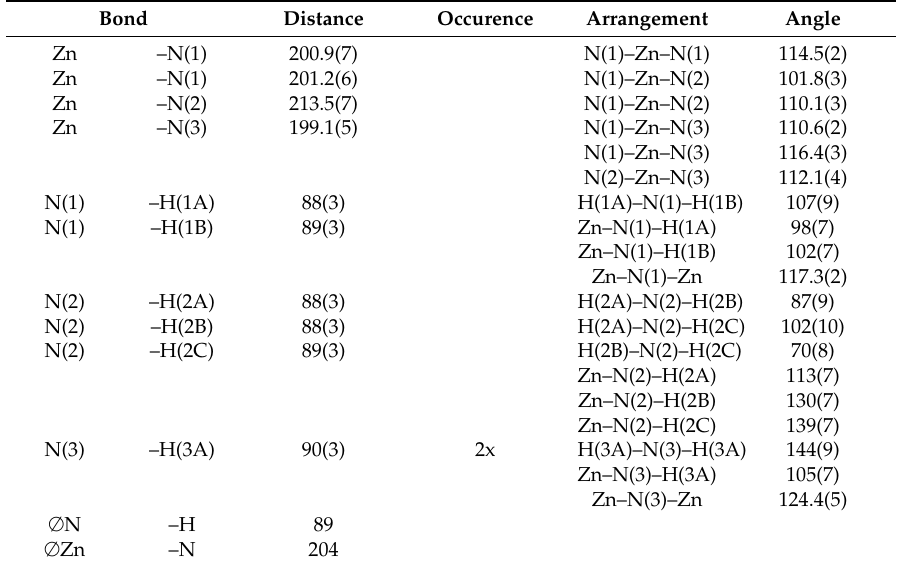
Table 3. Selected interatomic distances (pm) and angles (deg.) in the crystal structure of